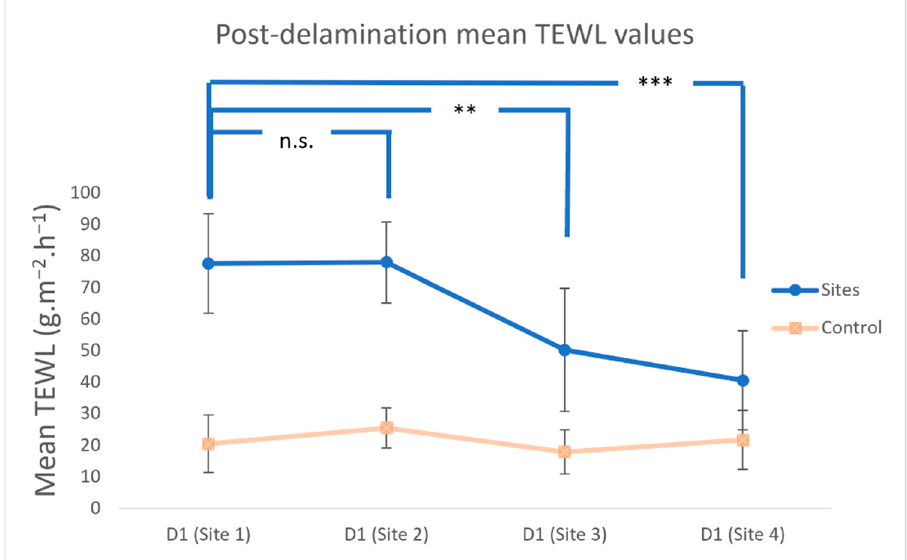
Figure 3. Means and standard deviations of transepidermal water loss (TEWL) after the same number of tape strips for each week. The evaluated spot-on was applied at the end of each week. (*** p < 0.001; ** p < 0.01; n.s., not significantly different from baseline).